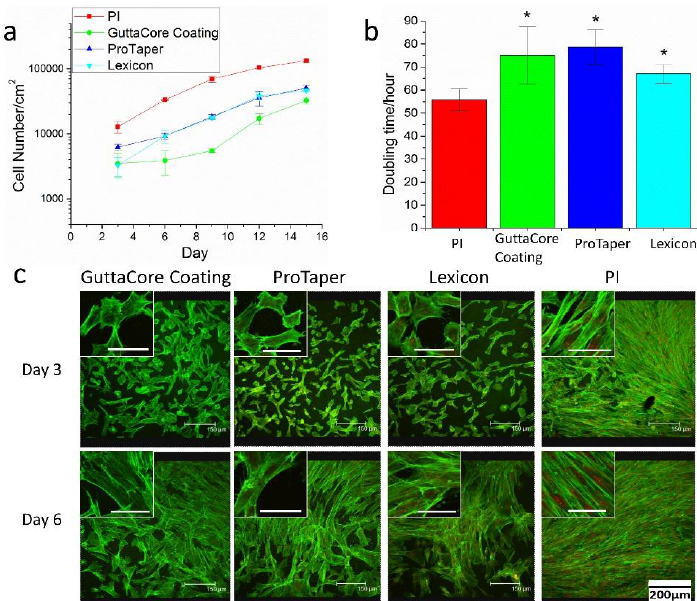
Figure 4. ( a ) Proliferation curves of DPSC plated, at an initial cell density of 10,000/cm 2 on the Gutta-percha scaffolds (shown in Figure 1) and 25 nm spun cast PI thin films; ( b ) The doubling time of DPSC calculated from the data plotted in ( a ). The Gutta-percha samples differ from control sample at a statistical level of p > 0.05 (*); ( c ) Confocal microscopy images of DPSC plated on PI and on the three Gutta-percha scaffolds after 3 and 6 days in culture without dexamethasone. Actin filaments were stained with Alex Flour 488 (green) and nucleus was stained with propidium iodide (red). Inset: High magnification images of individual cells in the cultures without dexamethasone (scale bar is 50 μm).